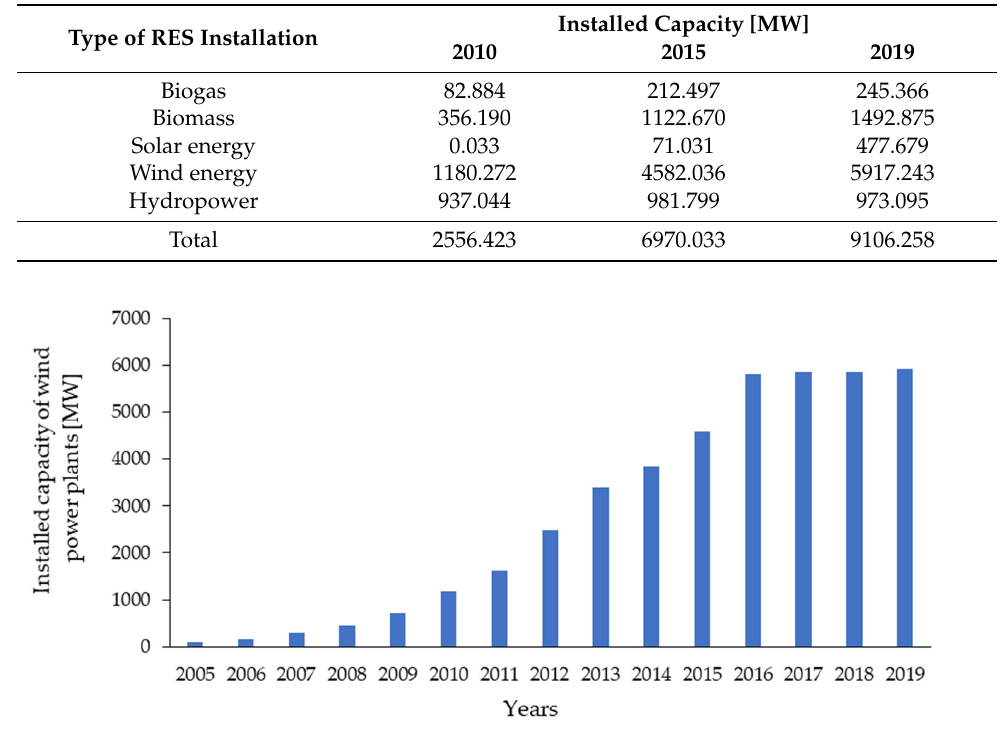
Figure 2. Installed capacity of wind power plants in Poland, 2005–2019 [3].